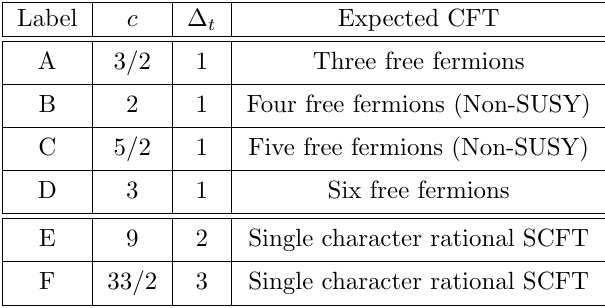
Table 2 . List of N = (1 ; 1) theories on the numerical boundary of (cid:12)gure 6, when the conserved currents with j (cid:21) 1 included in the 2